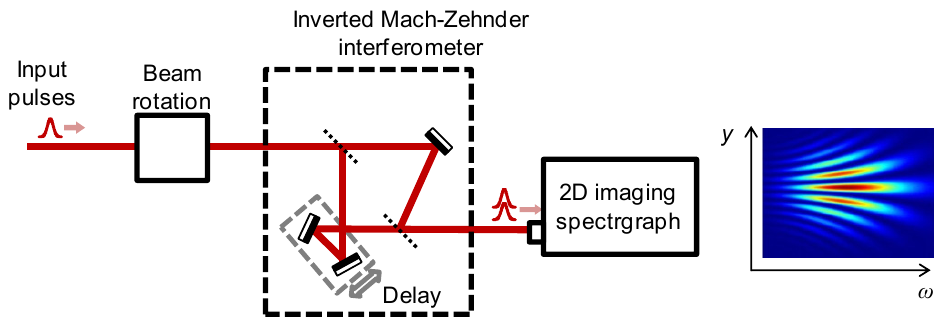
Figure 15. Experimental set-up of the interferometric detection of phase front angular dispersion with an inverted Mach–Zehnder